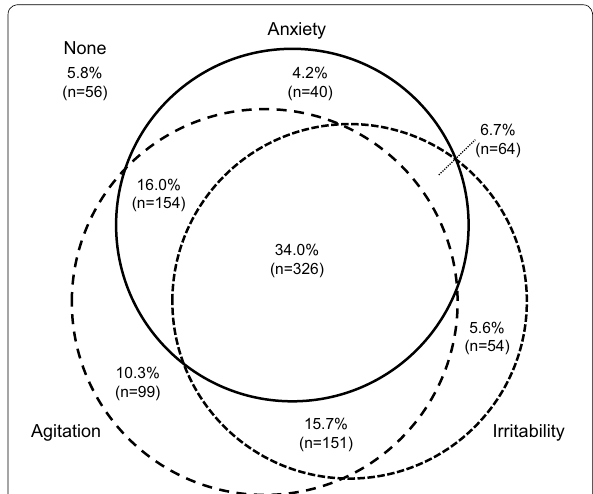
Fig. 1 Venn diagram displaying the overlap of comorbid AIA symp- toms in BD-I mania. Sixteen patients (1.7%) were missing a value for one or more AIA symptom at baseline and are not shown on the figure. Anxiety was defined as a PANSS anxiety item score of 3 at ≥ baseline. Irritability was defined as a YMRS irritability item score of 4 ≥ at baseline. Agitation was defined as a YMRS increased motor activ- ity–energy item score of 3 at baseline. Percentages are calculated ≥ from the full analysis set, which comprised 960 patients. AIA, anxiety, irritability, and agitation; BD-I, bipolar I disorder; PANSS, Positive and Negative Syndrome Scale; YMRS, Young Mania Rating Scale